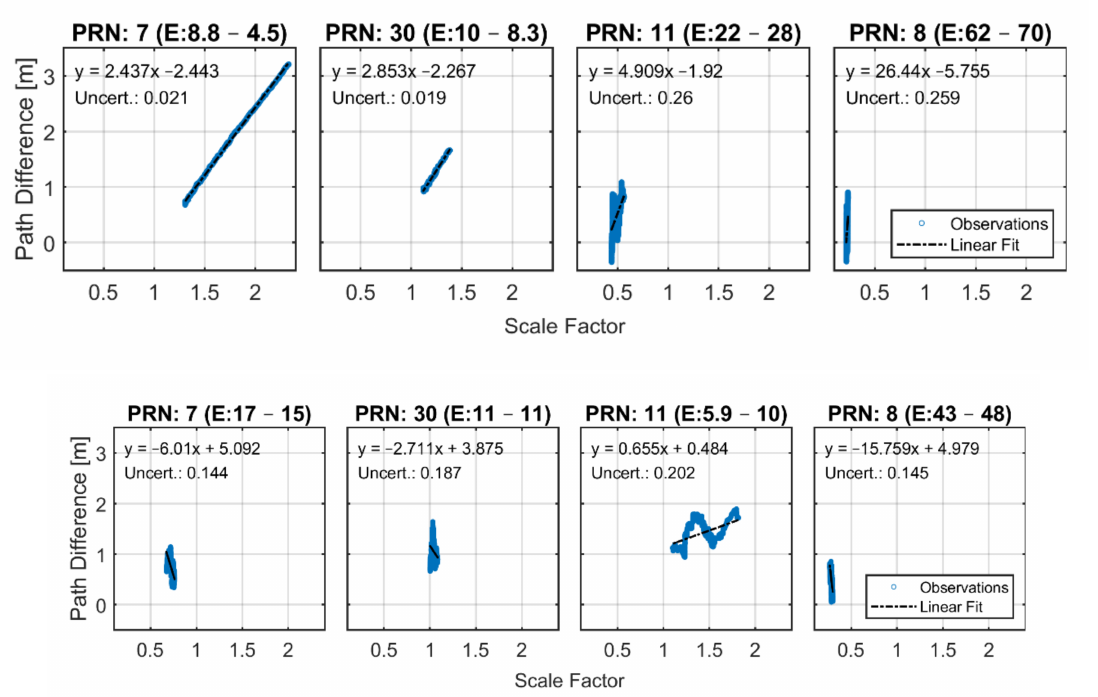
Figure 13. Residual phase (path difference representation) versus independent variable (scale factor) from the differential tropospheric delay approximation using the VFM3 and the height variation factor on 17 July 2019 (top row) and 15 July 2019 (bottom row). The linear regression equation and model uncertainty is presented in the top-left corner for each